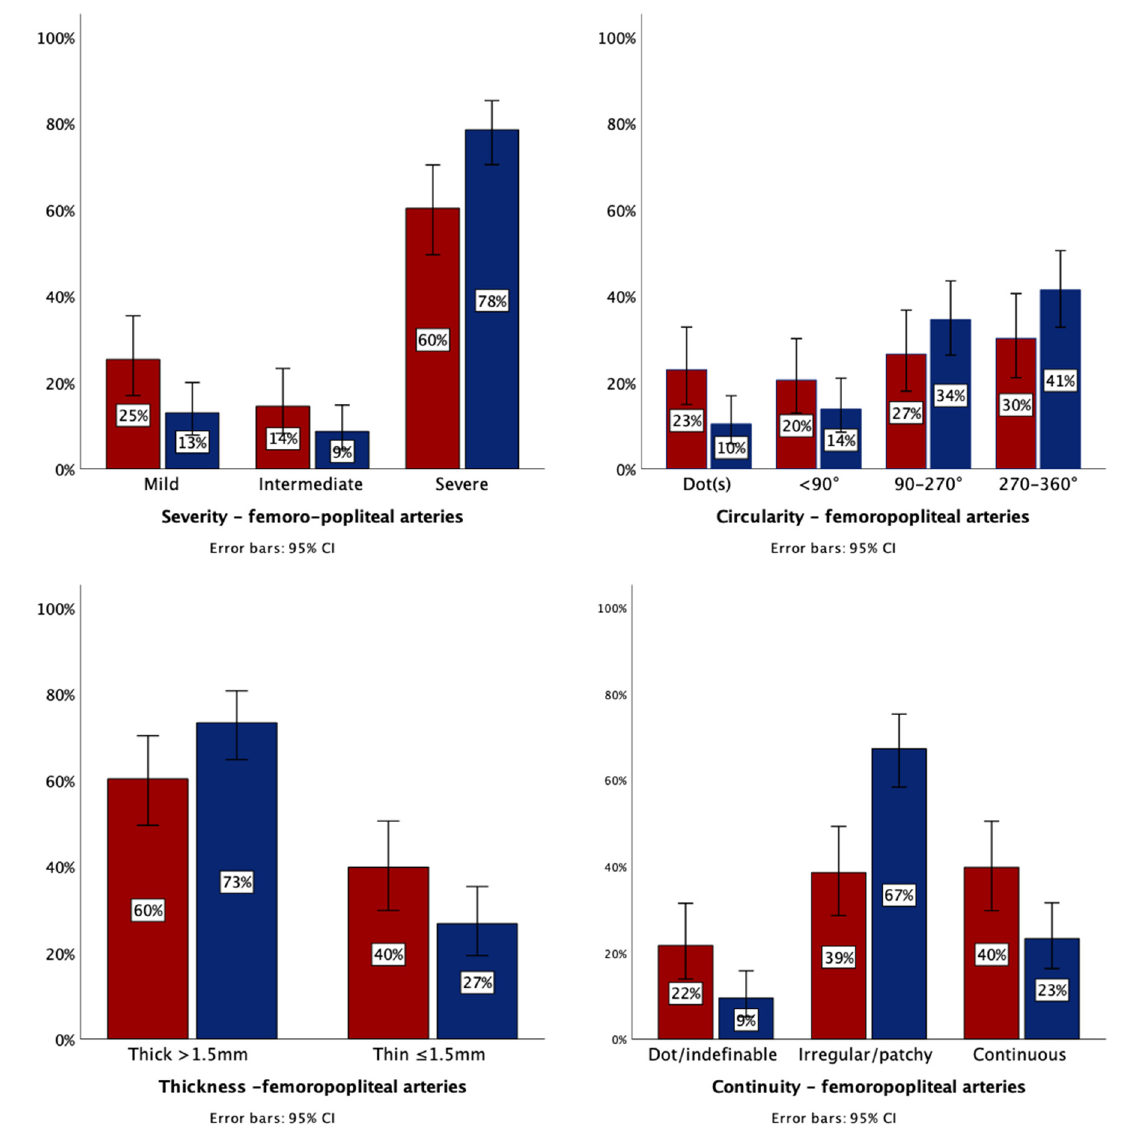
Figure 3. ( A ) CT calcification characteristics in the crural arteries as percentage of total number of age-matched patients. Red: non-PAD patients (n = 65). Blue: CLI patients (n = 115). ( B ) Severity, annularity, thickness, and continuity in the femoropopliteal arteries as percentage of total number of patients. Red: non-PAD patients (n = 83), blue: CLI patients (n = 116). Table 2. Multivariate logistic regression analysis (sex-adjusted) was performed to determine the different calcification characteristics in the crural arteries associated to age-matched non-PAD (n = 65) and CLI patients (n = 115). The patients without calcifications were excluded from this analysis. Standard Error Variables in the Equation OR 95% CI of the